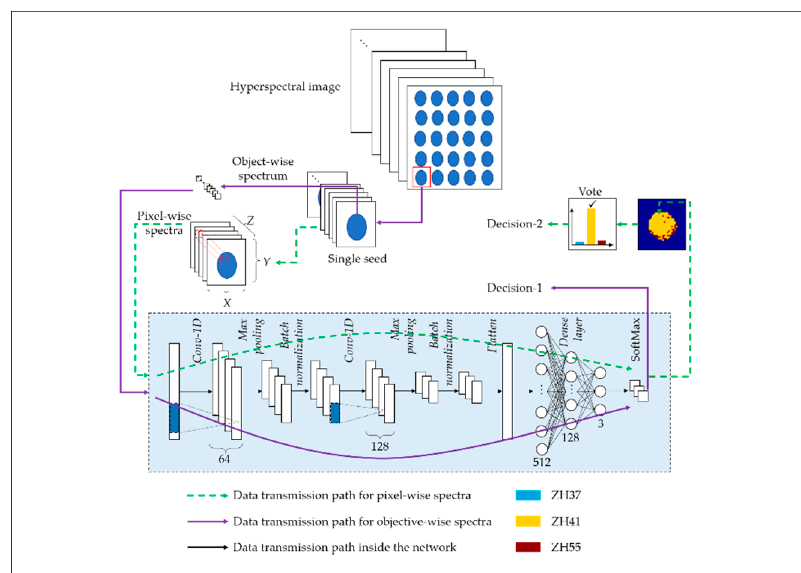
Figure 3. The block diagram of proposed majority vote strategy based on pixel-level spectra and conventional strategy based on mean spectra for a convolutional neural networks (CNN)-based